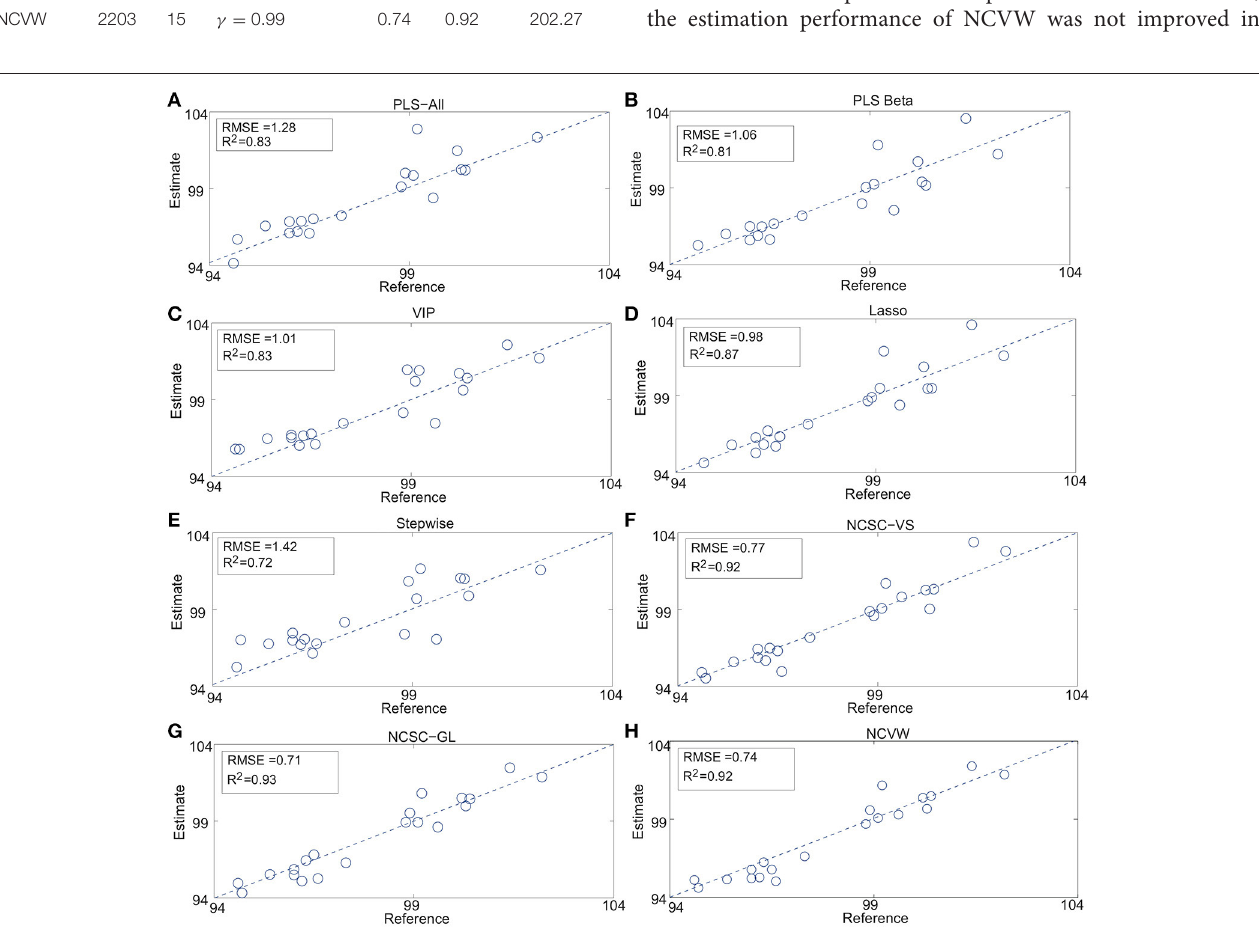
FIGURE 2 | API content estimation results: (A) PLS-All, (B) PLS Beta, (C) VIP, (D) Lasso, (E) Stepwise, (F) NCSC-VS, (G) NCSC-GL and, (H) NCVW (Fujiwara et al., 2010, 2012a,b).